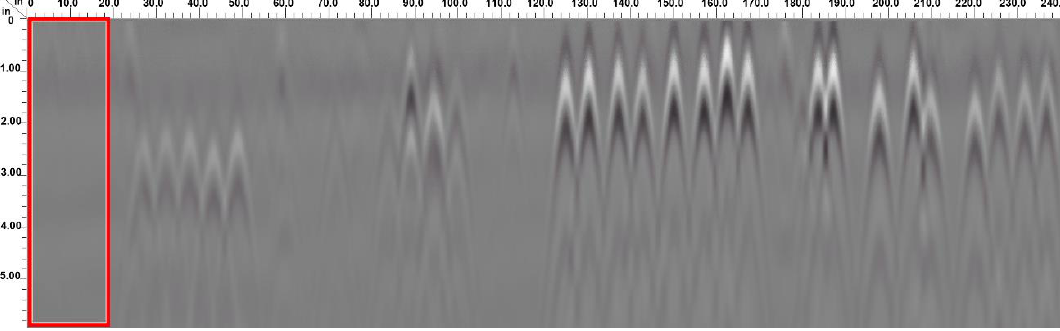
Figure 11. One B-Scan image of No. 11 timber.